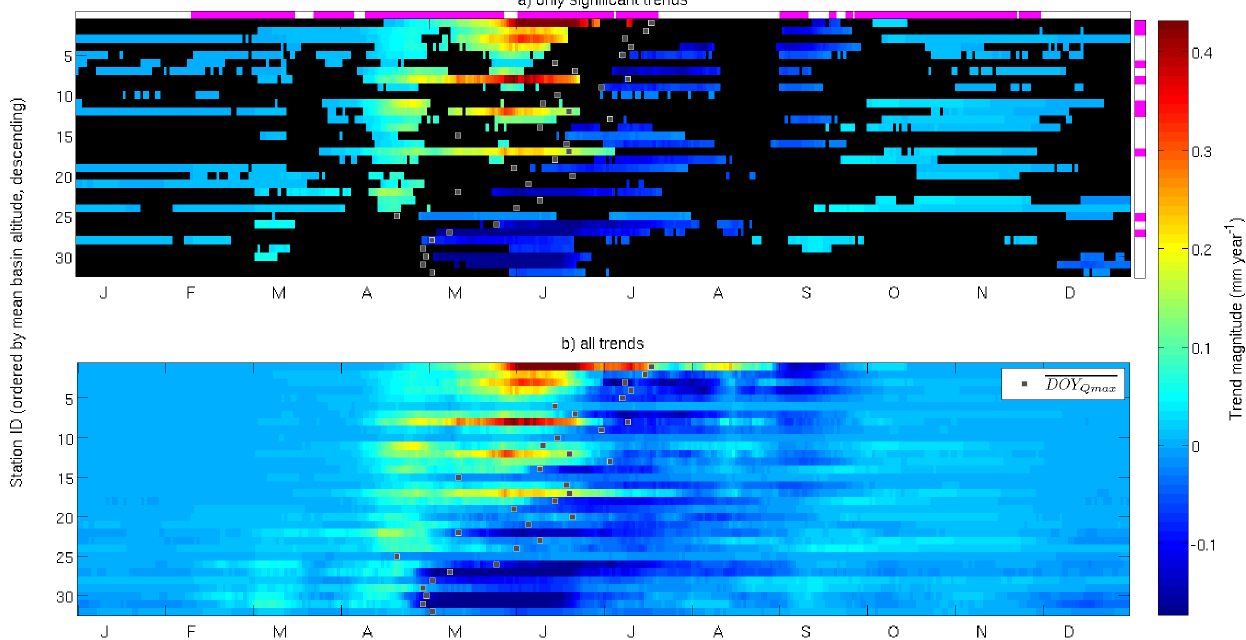
Figure 3. Seasonal distribution of daily streamflow trends (period: 1980–2010; significance level: α = 0.1); (a) 30DMA trend magnitude, only where significant trends are detected (dark blue if not significant); (b) significant and insignificant 30 DMA trend magnitudes; bar above upper diagram: pink if the 30DMA trends are field-significant; bar on the right of upper diagram: pink if the annual streamflow trend of the corresponding station is significant.